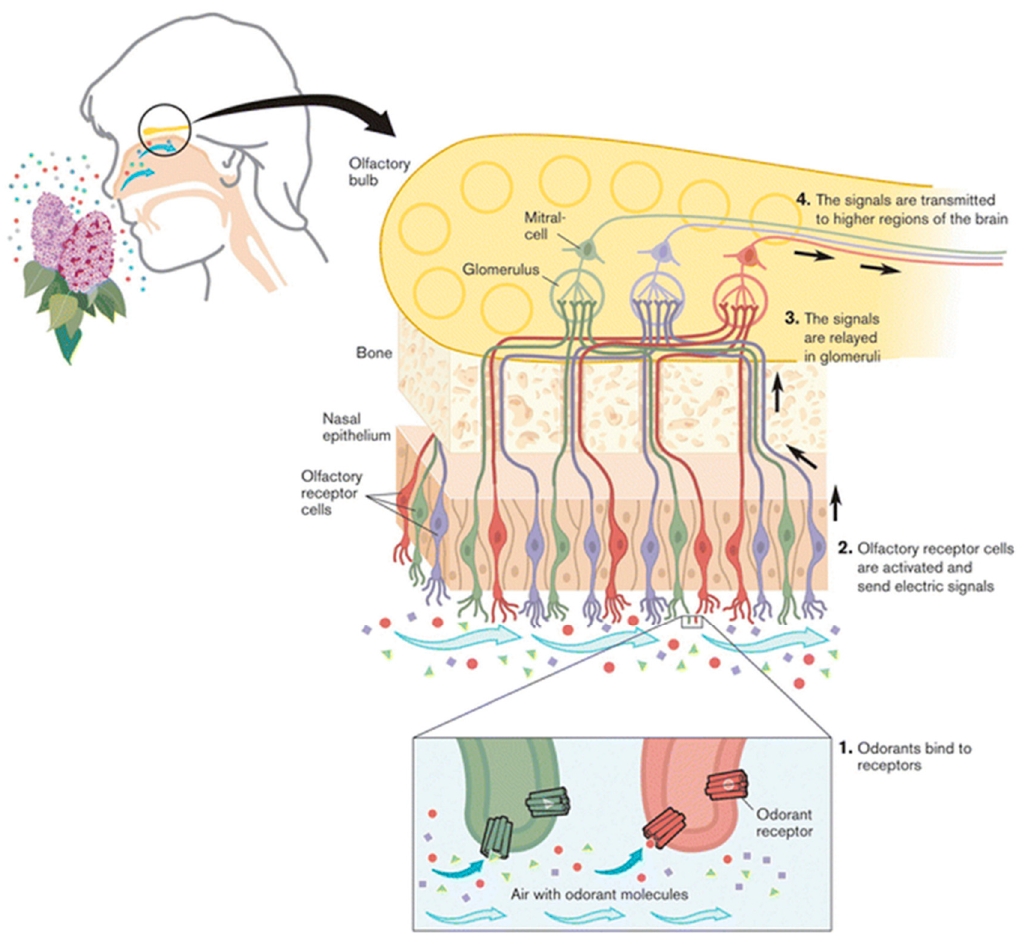
Figure 11. The human olfactory system. Reproduced from Ref. [107] with permission from Springer Nature, 2018.